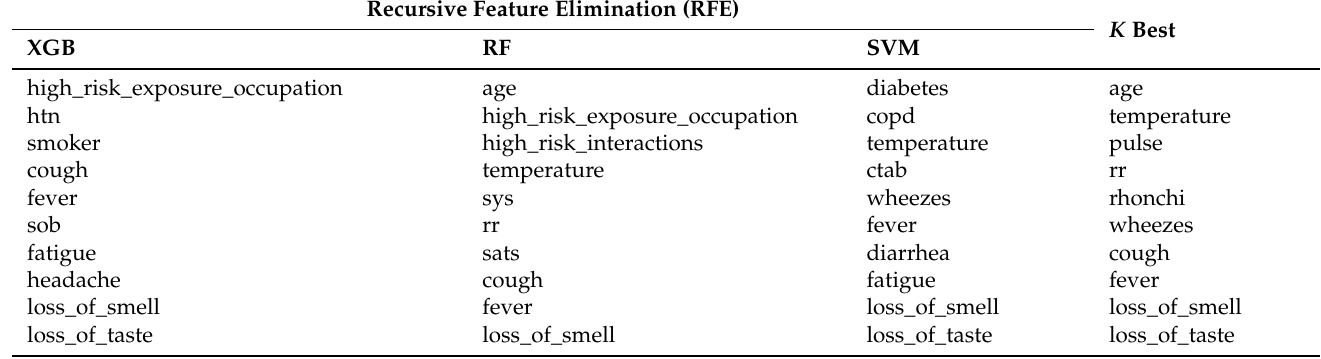
Table 2. The decided attributes come from two different selection algorithms. Various features have been chosen to be applied via RFE. By applying K Best, the last 10 features are selected for applying classification models. Recursive Feature Elimination